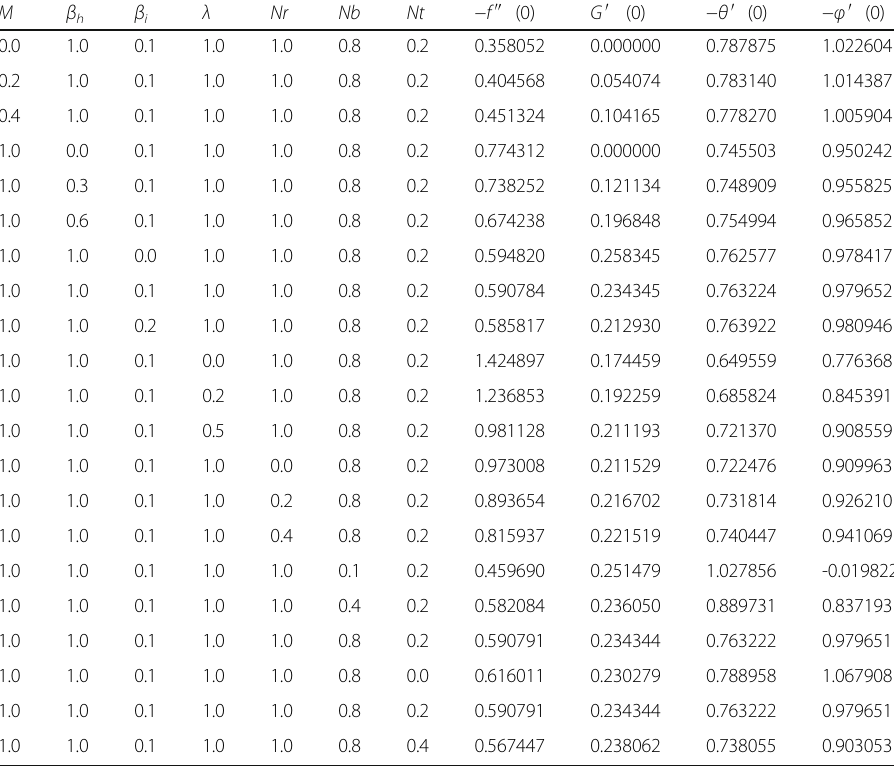
Table 3 Numerical values of the skin friction coefficients − f ″ (0) and G ′ (0), local Nusselt number − θ ′ (0), and local Sherwood number − φ ′ (0) for various values of M , β and Nt when K = 0.5, Pr = 1, and Le = 1 are